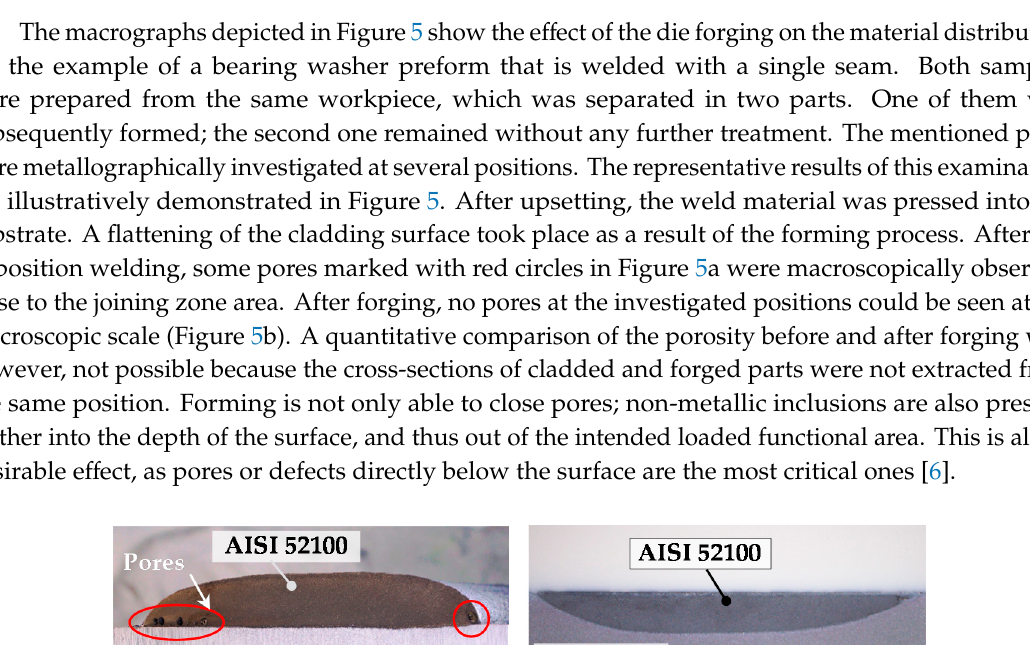
Figure 4. Forming setup: ( a ) hydraulic press; ( b ) removal of the shielding gas container from the furnace after heating of the workpieces; ( c ) forged bearing washer.